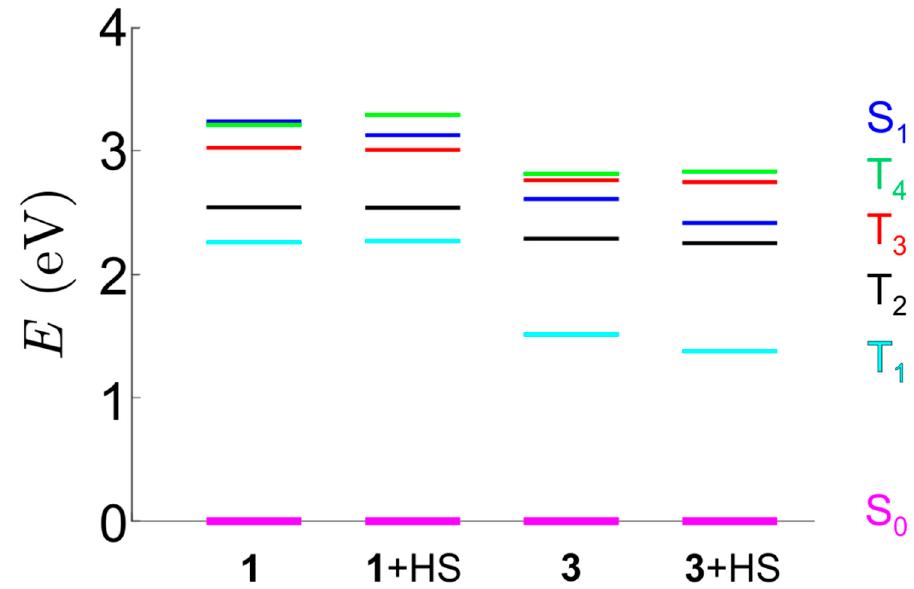
Figure 10. Computed energies ( E , eV) of the ground state (S 0 ) first excited singlet (S 1 ), and four lowest energy triplet states, evaluated at the S 0 geometry for complex 1 and complex 4 , and their HS – adducts.